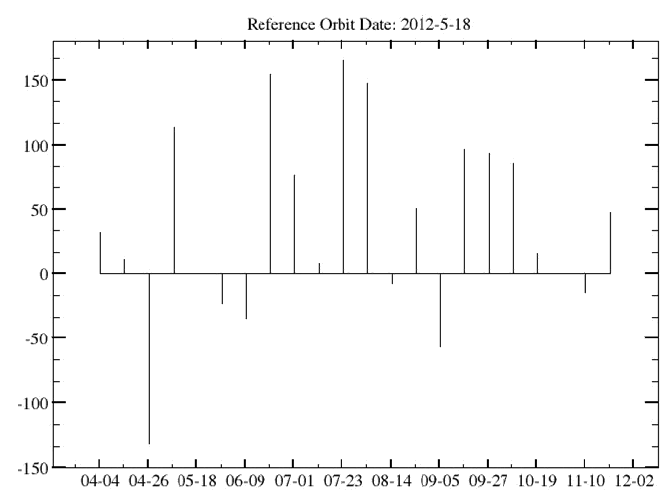
Figure 3. Baselines of TerraSAR-X data